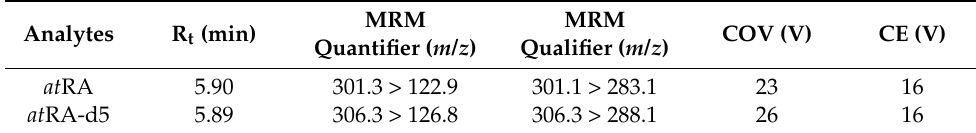
Table 1. Retention time (Rt), mass transition (MRM), cone voltage (COV), and collision energy (CE) for at RA and at RA-d5.